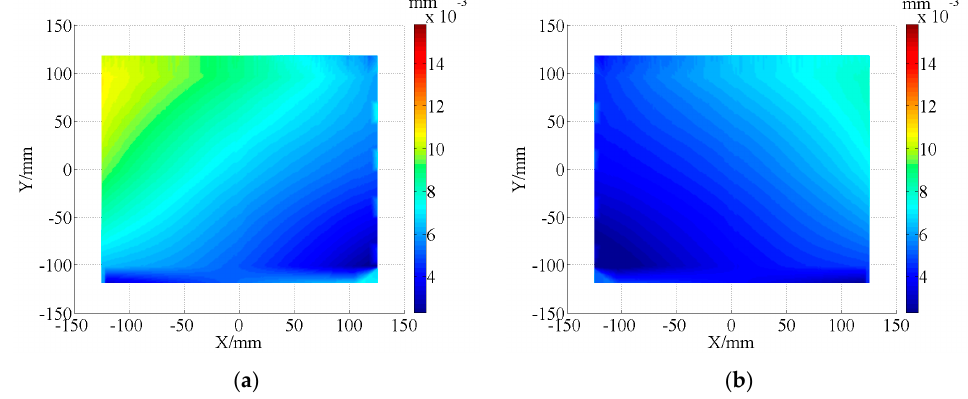
Figure 10. Error distribution of the freeform component machining with paraffin filled. ( a ) Error distribution of concave surface 2; ( b ) Error distribution of convex surface 2.